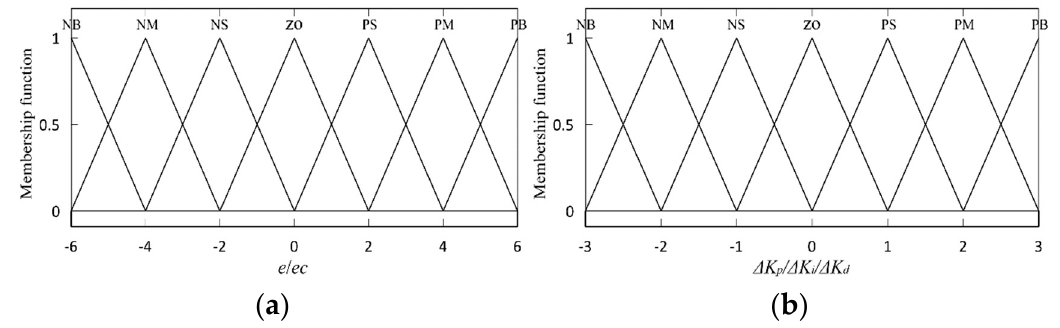
Figure 5. Input and output variable membership function: ( a ) Membership function of the input variables e , ec ; ( b ) membership function of the output variables ∆ K p , ∆ K i , and ∆ K d .